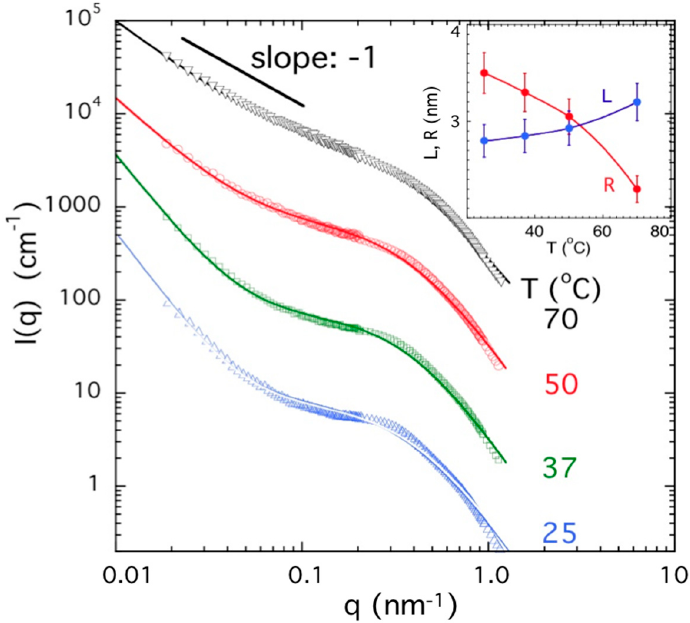
Figure 8. Temperature dependence of the SANS profiles of the 5 mass % gelator sample. For clarity, the curves are shifted by a factor of 10 with increasing temperatures. The continuous lines through the data points are least squares fits of Equation (3). The inset shows the variation of R and L as a function of T .